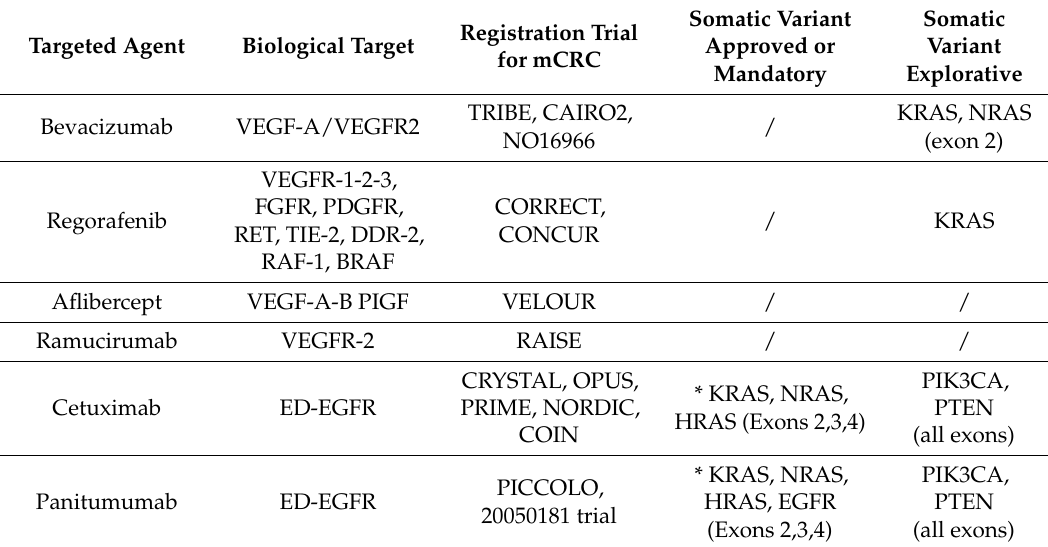
Table 2. Pharmacogenomic value of the most studied genetic